Question: Sum up the contents of this chart in one sentence.
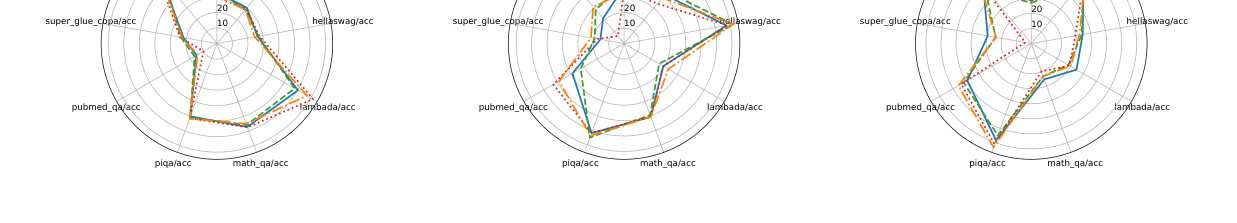
Answer: The average accuracy scores across nine language reasoning tasks. From left to right: unlearning 8 samples, 16 samples, and 32 samples at once, respectively. Results based on the 125 million checkpoint.